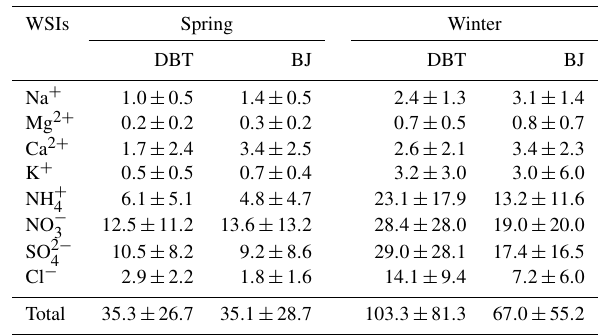
Table 1. The average mass concentrations of WSIs in PM 2 . 5 at DBT and BJ during the sampling period in winter and spring of 2014– 2015 (µgm − 3